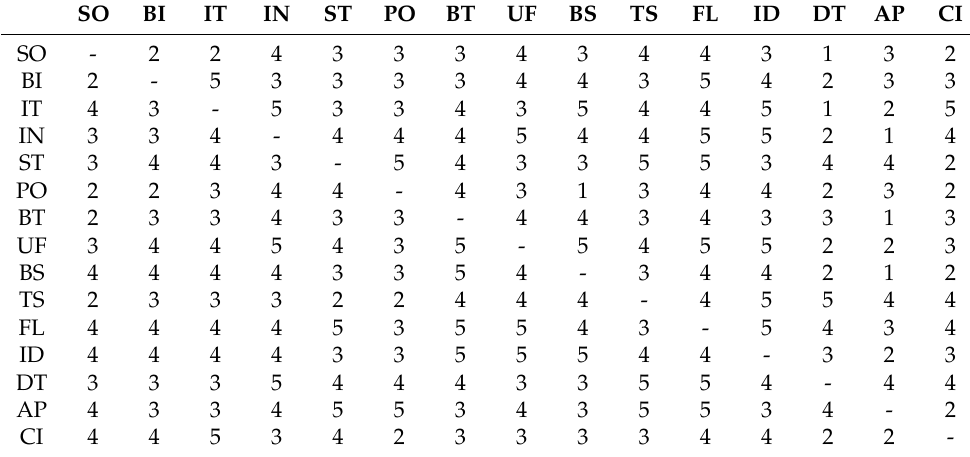
Table 7. Direct relation matrix.